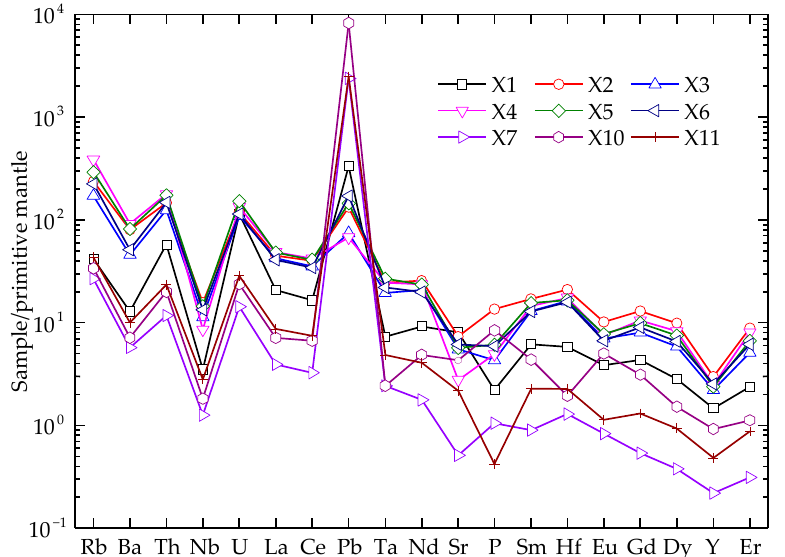
Figure 6. Primitive mantle-normalized trace element distribution patterns of ore from Xiaojiashan gold deposit.